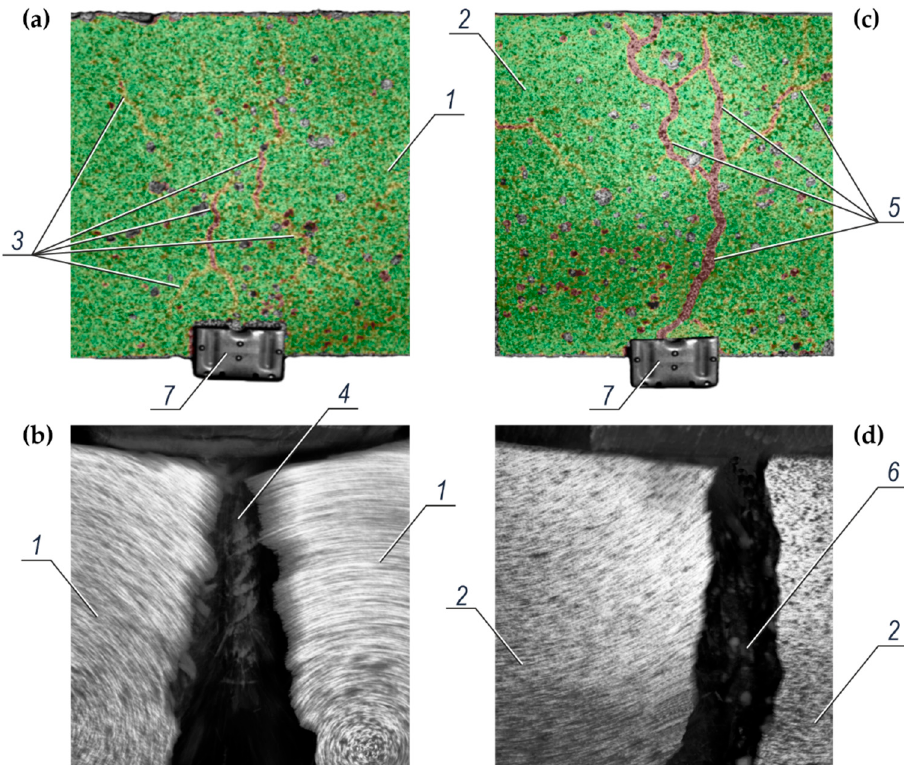
Figure 11. The analysis of the surface of concrete specimens with chlorides during the pull-out of ribbed rebars φ 16 mm after 540 days from their preparation, which was conducted using the Aramis system: ( a ) surface of the specimen 1 (with a black steel rebar) and hardly visible dispersed brown grid 3 of displaced points sprayed with graphite paint, ( b ) the moment of rapid cracking 4 of concrete in the specimen 1 in the grid zone 3 , ( c ) surface of the specimen 2 (with the galvanized rebar) and very clear condensed brown grid 5 of displaced points, ( d ) the moment of rapid asymmetrical cracking 6 of concrete in the specimen 2 in the grid zone 5 ; 7 —plate with permanent measuring points glued to the pulled out